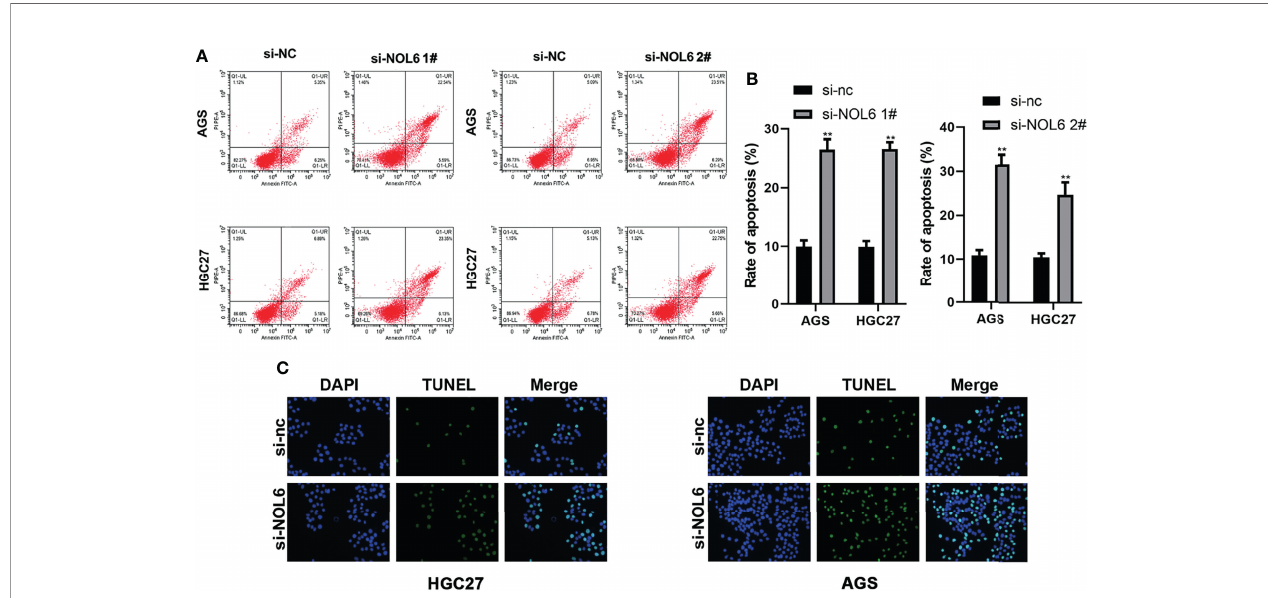
FIGURE 5 | NOL6 knockdown promoted the apoptosis of AGS and HGC cells. (A, B) Flow cytometry was performed to measure the apoptosis rate of AGS and HGC cells. (C) The apoptosis of AGS and HGC cells by the TUNEL staining. (**p < 0.01,